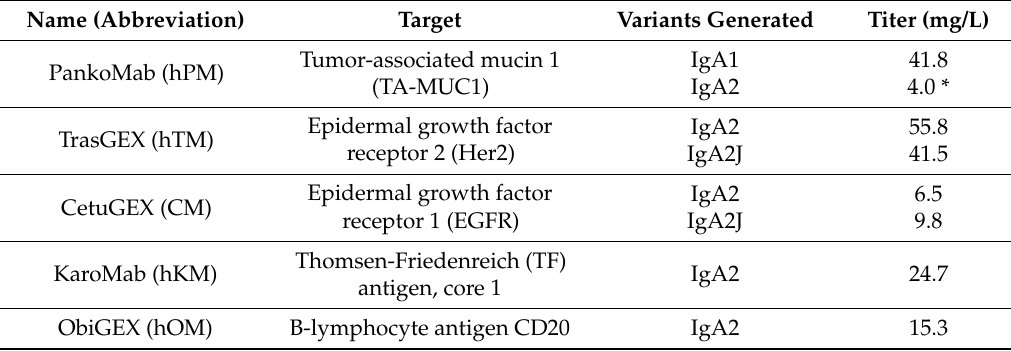
Table 1. Overview of the targets, isotypes and production levels of the generated IgA